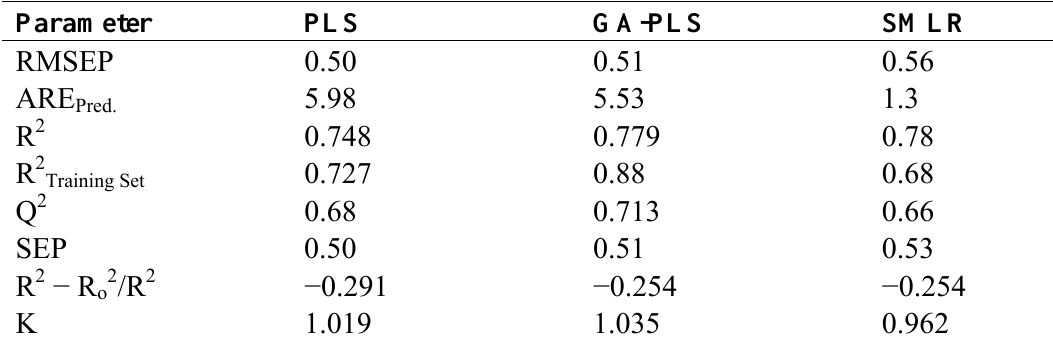
Table 8. Statistical parameters obtained by applying the PLS, GA-PLS and